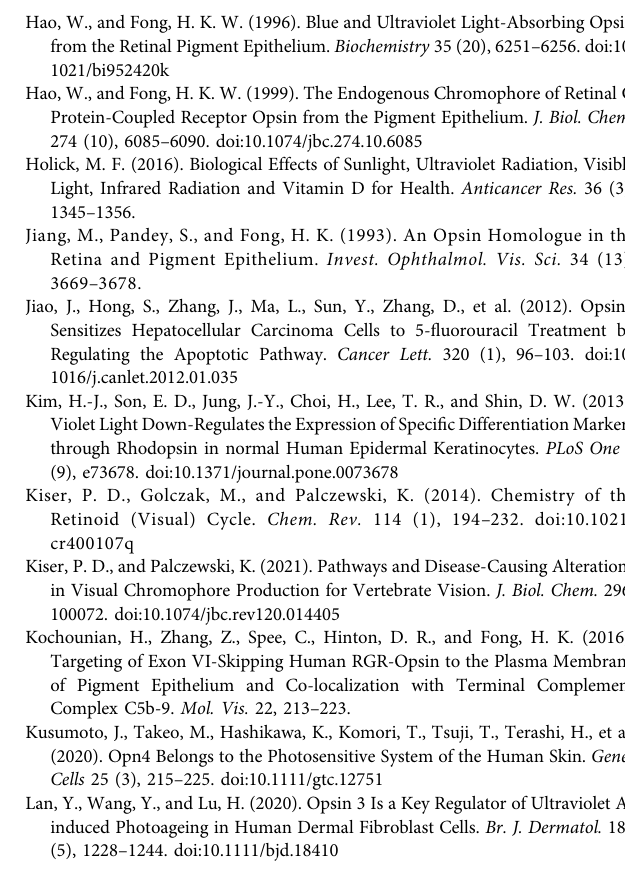
Supplementary Figure S1 | RGR regulates the proliferation, migration, and apoptosis of HaCaT cell line. (A) Representative HaCaT cell lines after lentivirus transfection with control group, knockdown group, and overexpression group RGR protein by WB assay analysis. β -Tubulin as a loading control. The relative protein levels of RGR and β -tubulin were measured using ImageJ software (n = 3 independent experiments). **p < 0.01, ***p < 0.001. (B) Flow cytometry was used to detect the cell cycle. Following lentivirus transfection RGR knockdown, compared with the LV-control-RNAi, lentivirus transfection knockdown RGR HaCaT cell line has a signi fi cant decrease in the percentage of S-phase cells at 24 h. Compared with the LV control, lentivirus-transfected RGR overexpression HaCaT cells detected a signi fi cant increase in the percentage of S-phase cells at 24 h. *p < 0.05, **p < 0.01. (C) Representative wound healing assay demonstrated that the lentivirus transfection RGR knockdown group signi fi cantly decreased cell mobility compared with the LV control RNAi group. Compared with the LV control group, the lentivirus transfection RGRoverexpressiongroup had increased mobility. Scalebar=50 μ m.**p < 0.01,***p < 0.001. (D) FlowcytometrywithannexinV-APC/ PIdoublestainingwasusedtodetermineapoptoticcells.Followingtransfectionwith lentivirus, compared with the LV control RNAi group, the lentivirus-transfected RGR knockdown HaCaT cells had a higher rate of cell apoptosis. Compared to LV controls, lentivirus-transfected RGR overexpression was not signi fi cantly different apoptosis rate. ***p < 0.001. (E) In the Transwell assay, compared with the LV control RNAi group, lentivirus-transfected RGR knockdown HaCaT cells had signi fi cant reduced migration ability. Compared with the LV control group, the lentivirus-transfected overexpression RGR HaCaT cells did not signi fi cantly increase migration. Scale = 50 μ m. ***p <